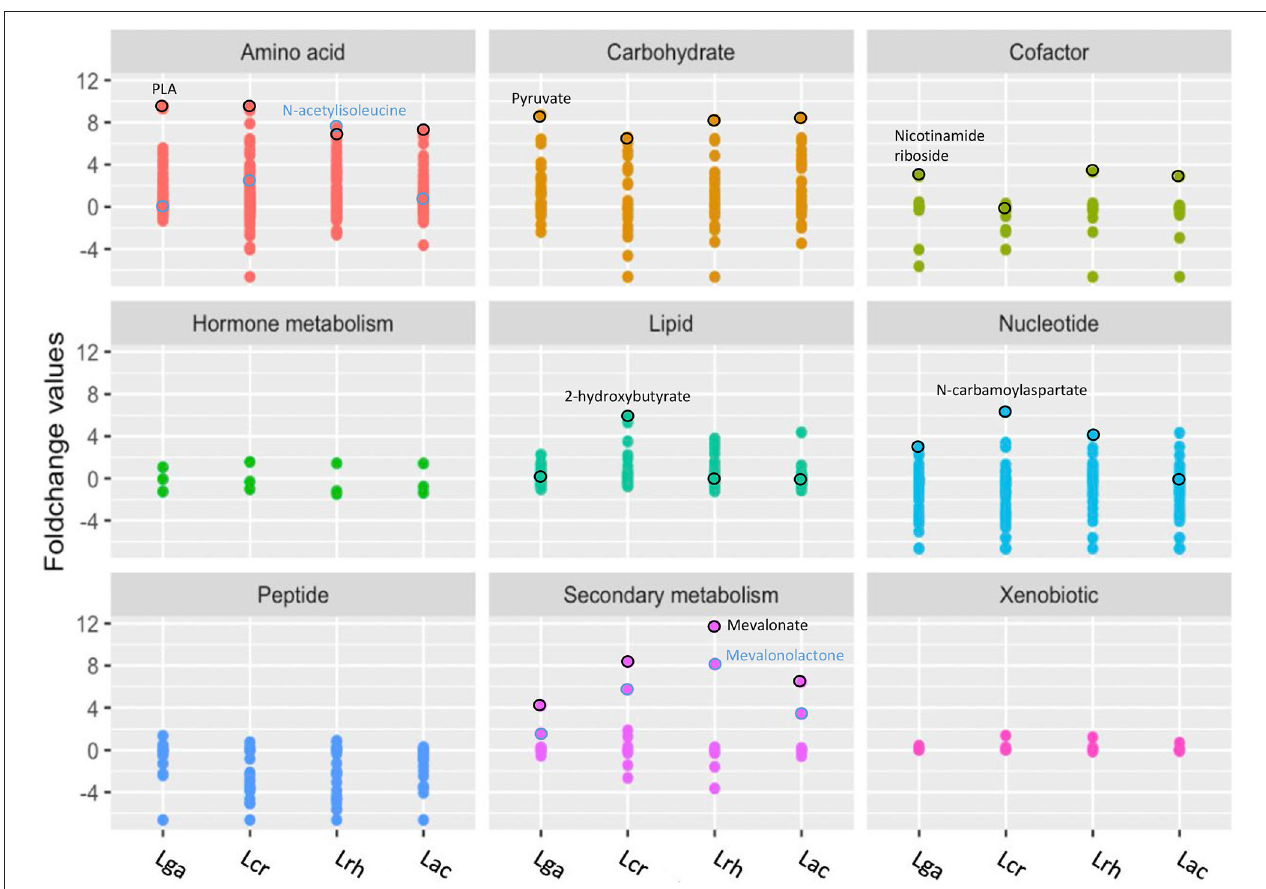
FIGURE 4 | Representation of the global metabolic profile of Lactobacillus strains based on super pathway analysis. Significant ( p ≤ 0.05) log2 transformed fold change values for each metabolite were used for mapping to nine biochemical pathways. Distinct colors and grids indicate the overarching biochemical pathway for the detected metabolites. Outlined circles (black and blue) indicate highly detected and unique metabolites for each strain. L. acidophilus NCFM (Lac), L. crispatus NCK1351 (Lcr) , L. gasseri NCK1342 (Lga), and L. rhamnosus GG (Lrh).